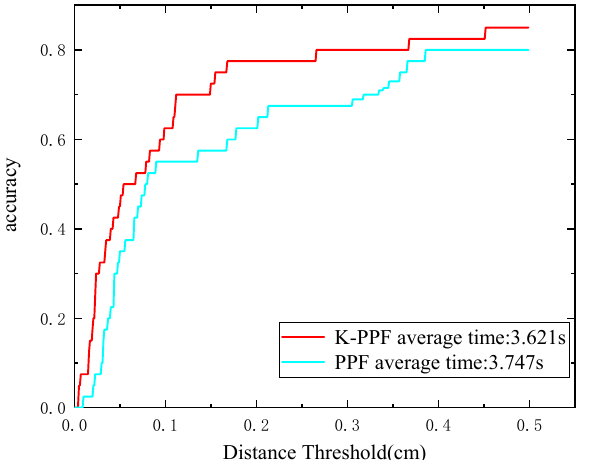
Figure 8. AUC comparison of K-PPF and PPF.